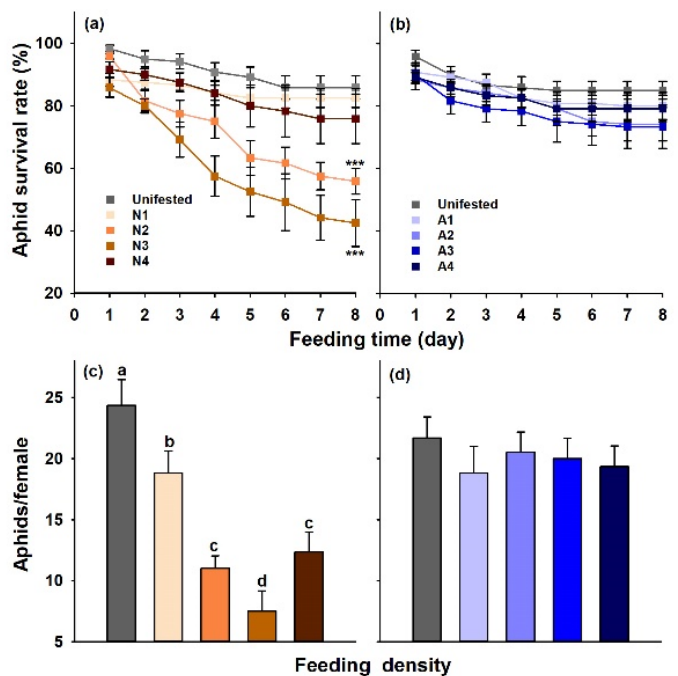
Figure 1. Performance of M. persicae on wild-type tobacco plants infested by B. tabaci MEAM1. Survival rate of M. persicae on tobacco plants infested by B. tabaci MEAM1 nymphs ( a ) and adults ( b ) at different densities. Fecundity of M. persicae on tobacco plants infested by B. tabaci MEAM1 nymphs ( c ) and adults ( d ) at different densities. Letters N1, N2, N3, and N4 indicate infesta- tion level of nymphs at 1–2, 5–6, 9–10, and 13–14 nymphs/cm 2 , respectively. Letters A1, A2, A3, and A4 represent adult infestation level of 50 ( ± 2)/leaf, 100 ( ± 5)/leaf, 200 ( ± 10)/leaf, and 400 ( ± 20)/leaf, respectively. Error bars represent standard error of the means. The different letters above the bars indicate values that are significantly different ( p <